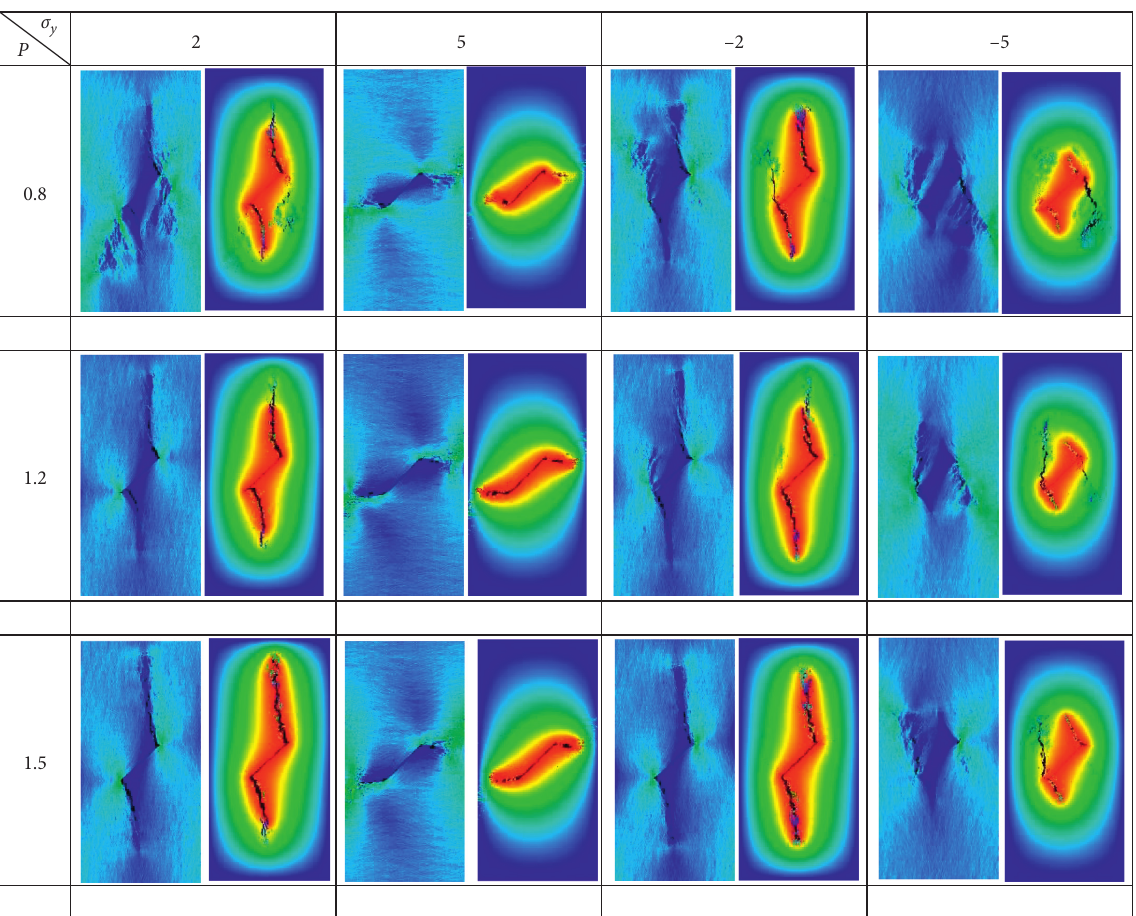
Figure 6: Evolution of shear stress and pore water pressure under confining compression and confining tension. A case of 45 ° : (a) confining compression; (b) confining tension.